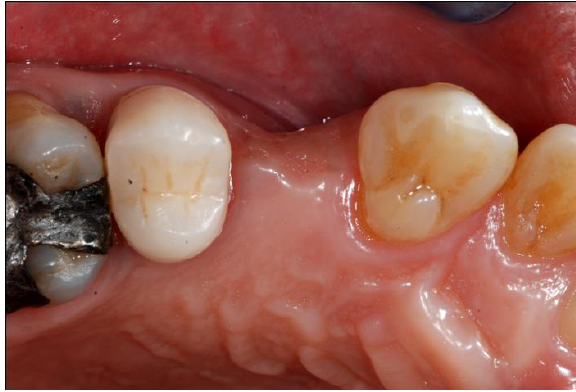
Figure 1. Presurgical clinical situation, occlusal view of the defect.